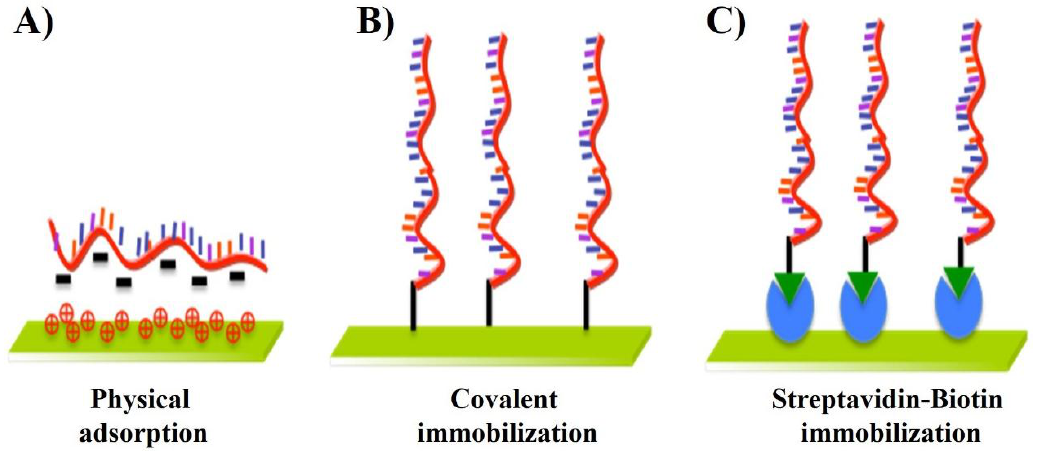
Figure 1. Immobilization techniques for fabrication DNA microarray.